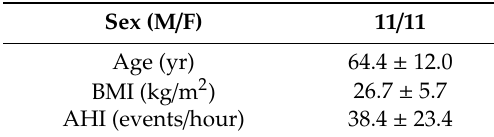
Table 3. Subject characteristics. Data are presented as the mean ± SD or n. (BMI, body mass index; AHI, apnoea-hypopnea index).